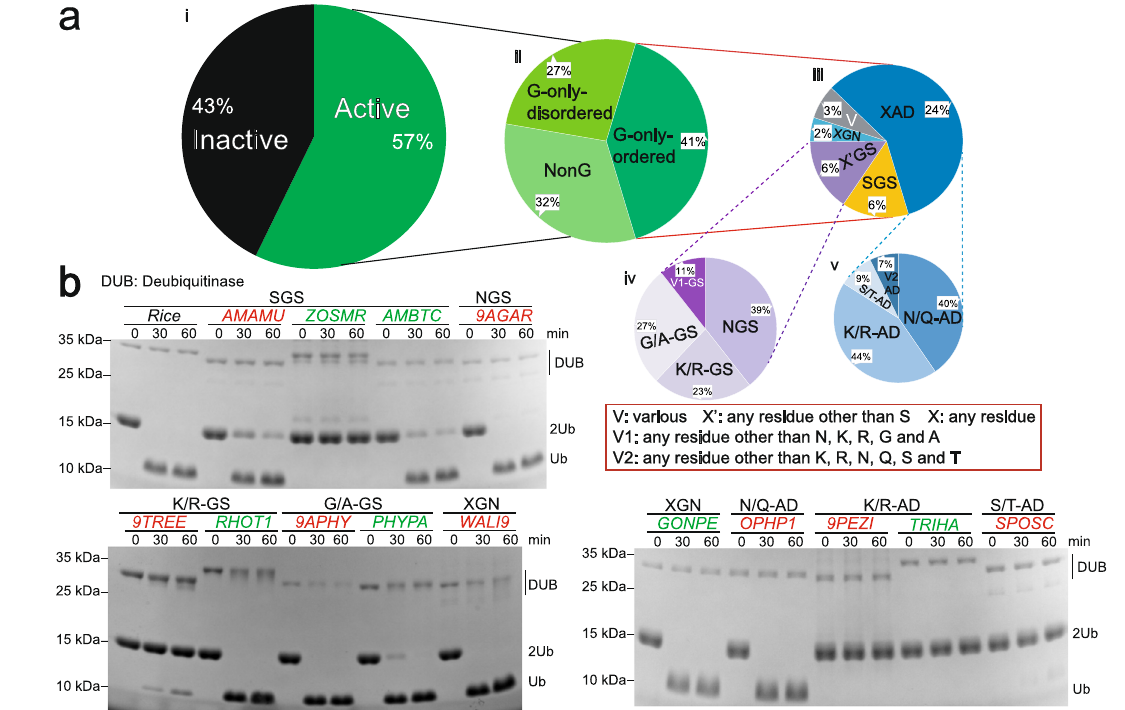
Fig. 4 | Met1-speci fi c motif rule is prevalent in members of OTUB subfamily. a Classi fi cation of C65peptidase familybased on characterization of catalytic triad andresiduesintwomotifsofS1 ’ pocket; b HydrolysisactivityagainstMet1-diUbby representative DUBs in every category ( N =3 biologically independent experi- ments). DUBs from species in red are the evolutionarily remotest ones from OsO- TUB1, while species in green are the ones other than fungus. AMAMU , Amanita muscaria Koide BX008; ZOSMR , Zostera marina ; AMBTC , Amborella trichopoda ;